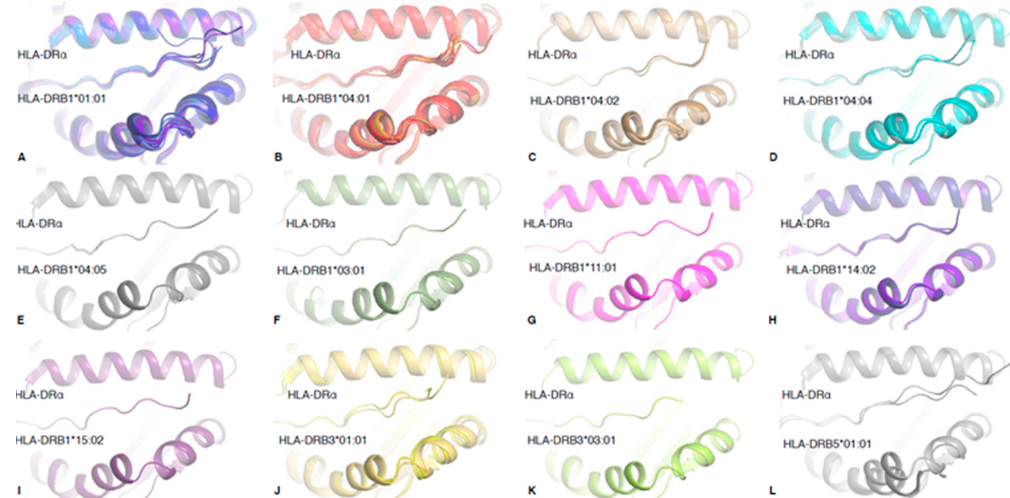
Figure 4. Overview of the available structures for pHLA-DR allomorphs. Crystal structures of the pHLA-DR complexes used for our analysis and reported in Table 1. Each structure of the same HLA-DR allomorph has been superimposed, and all pHLA-DR complexes are represented in the same orientation. The 12 available allomorph structures available are represented in ( A ) blue for HLA-DRB1 *01:01, ( B ) red for HLA-DRB1*04:01, ( C ) beige for HLA-DRB1*04:02, ( D ) cyan for HLA-DRB1 *04:04, ( E ) grey for HLA-DRB1*04:05, ( F ) green for HLA-DRB1*03:01, ( G ) pink for HLA-DRB1 *11:01, ( H ) bright purple for HLA-DRB1 *14:02, ( I ) dark purple for HLA-DRB1 *15:02, ( J ) yellow for HLA-DRB3*01:01, ( K ) lime for HLA-DRB3*03:01, and ( L ) grey for HLA-DRB5*01:01.